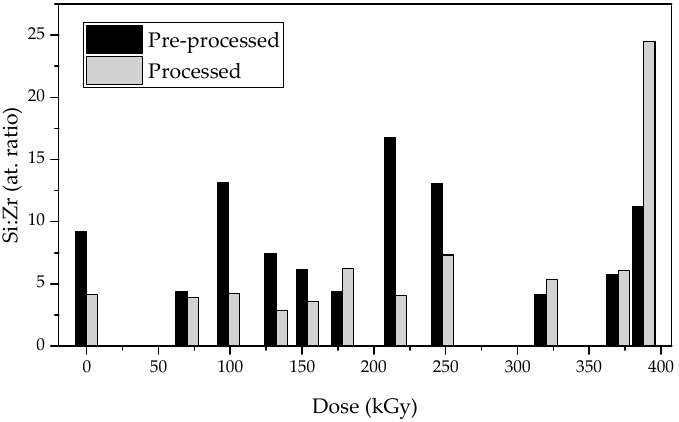
Figure 3. Si:Zr atomic ratio before and after processing for unreacted materials’ and fragments’ extraction.